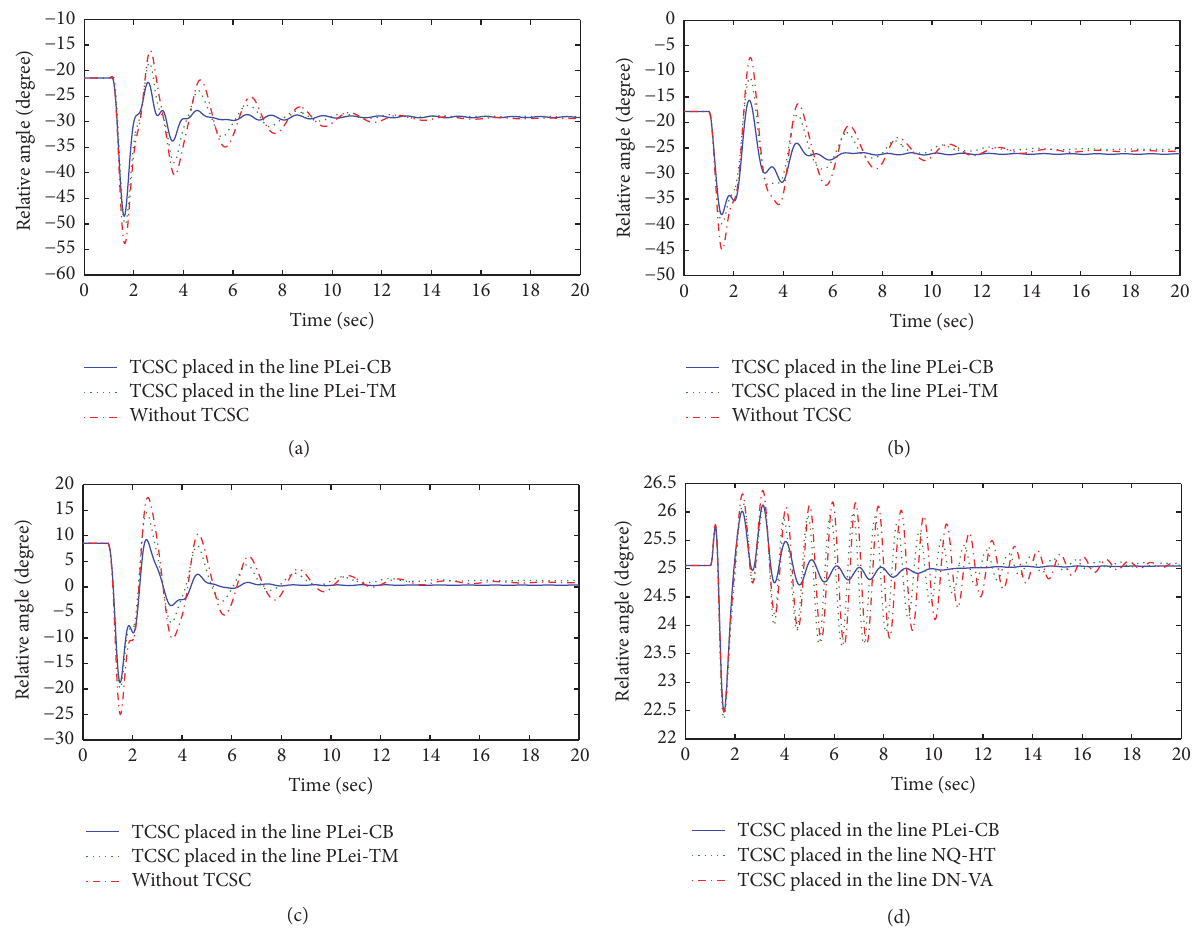
Figure 9: The relative angle oscillations of generators: (a) Yaly; (b) PhuMy-3; (c) VinhTan; (d) QuangNinh.